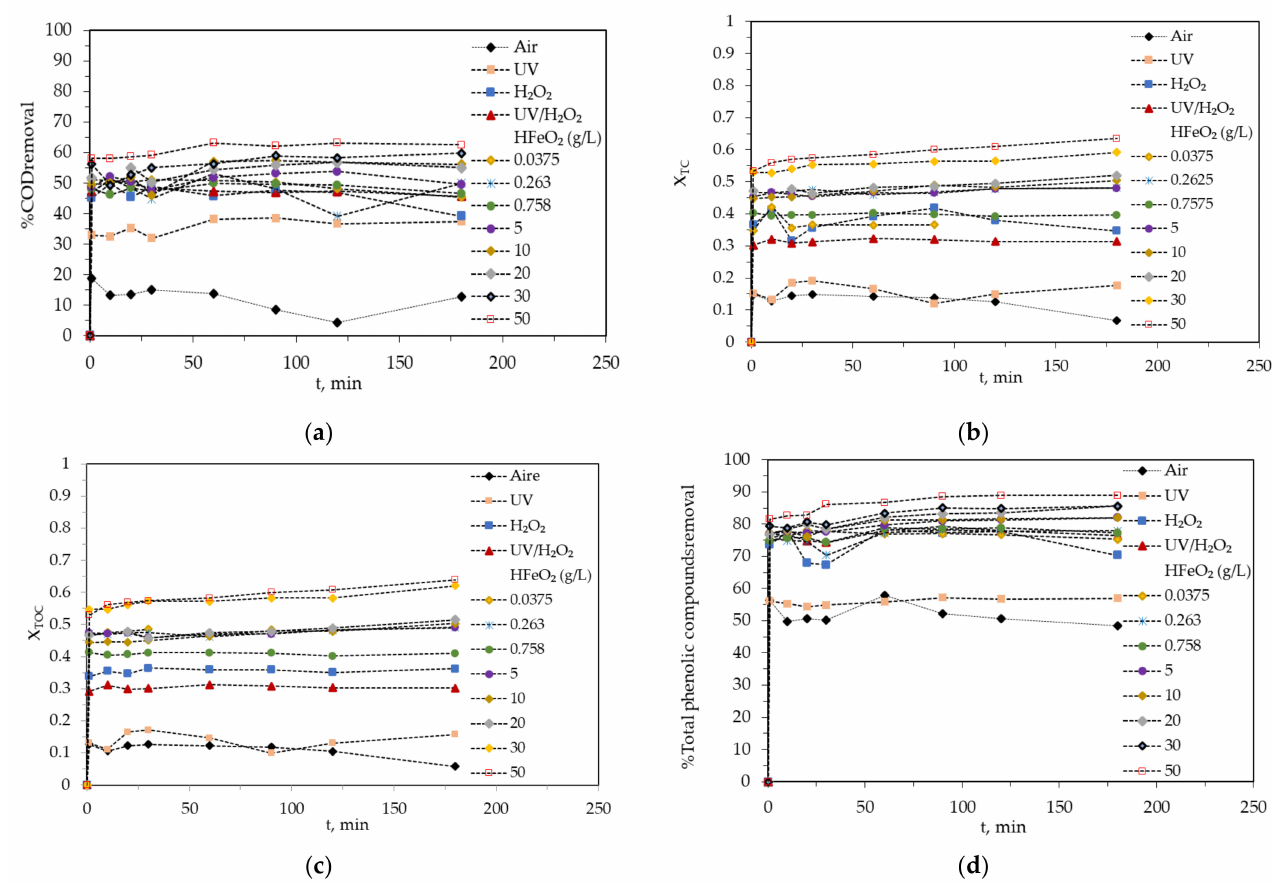
Figure 2. Variation of organic matter degradation of OMW throughout the experiment time for different chemical oxidation systems: air, UV, H 2 O 2 , UV/H 2 O 2 , and UV/catalyst/H 2 O 2 with different catalysts doses. ( a ) Removal percentages of COD, ( b ) conversion degree of total carbon, ( c ) conversion degree of total organic carbon, ( d ) removal percentages of total phenolic carbon. Common operating conditions: COD initial = 16586 mg O 2 /L, H 2 O 2 = 35.3 g/L, T = 20 ◦ C, agitation speed = 700 rpm, and pH =